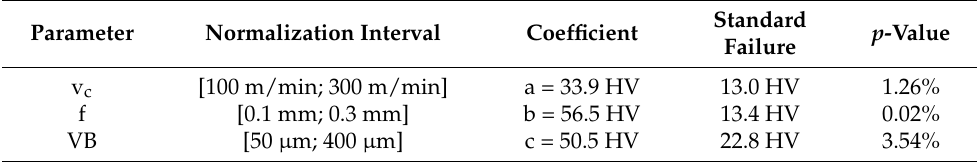
Table 1. Coefficients and failure values derived for the regression model in Equation (1).